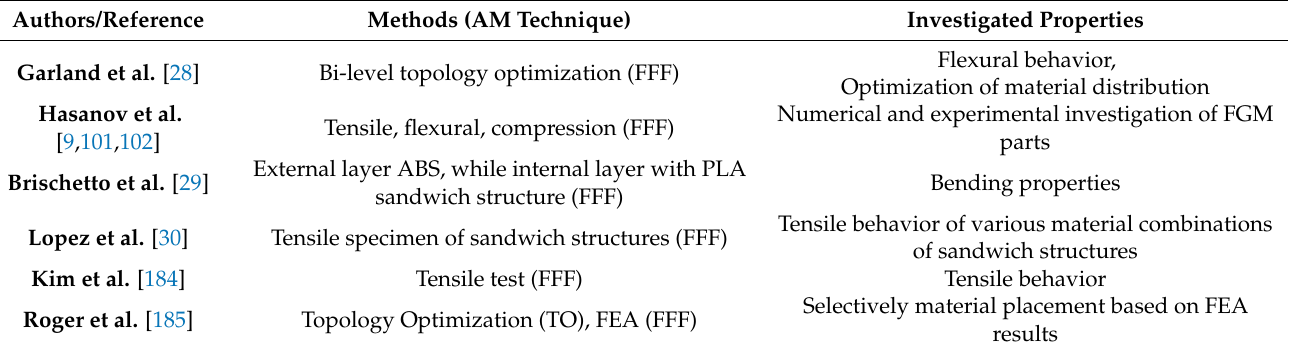
Table 5. Literature review of multi-material AM research